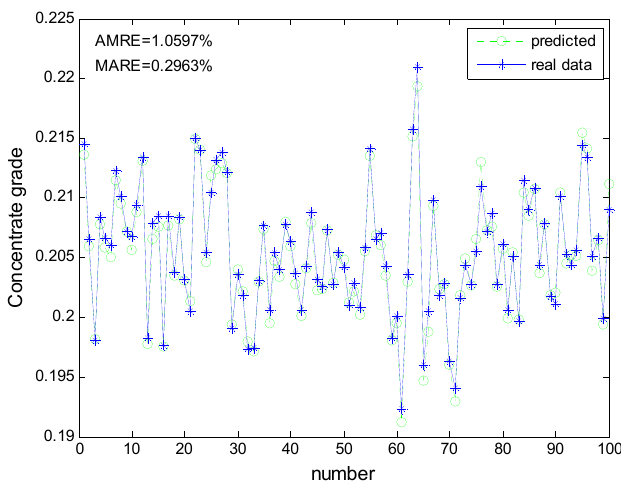
Figure 11. Concentrate grade of Cu predicted by artificial neural networks. Table 1. Comparison of back-propagation network results obtained with different nodes. Hidden Nodes